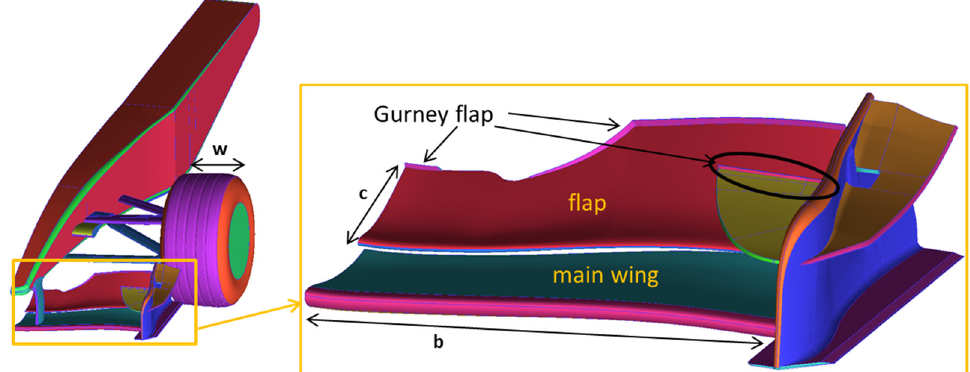
Figure 1. Geometry of the model and front wing with GF details.